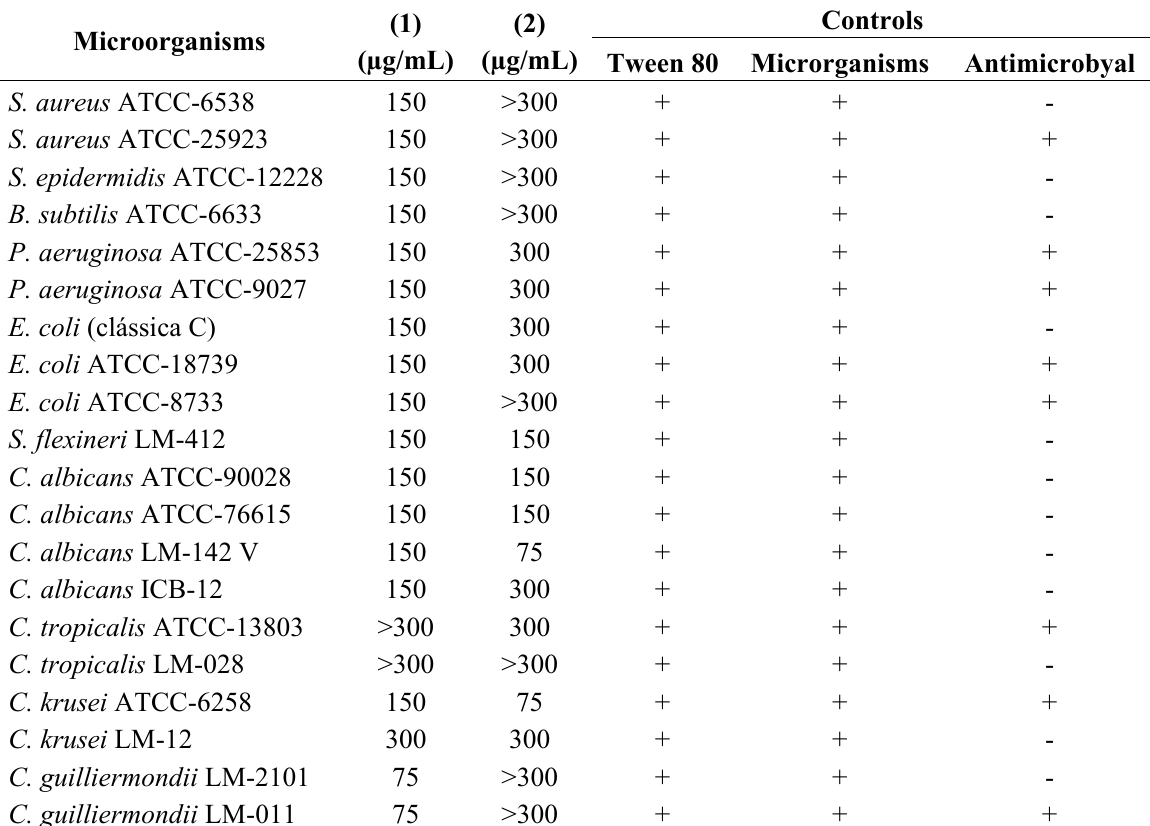
Table 1. MIC values of compounds 1 and 2 against bacteria and